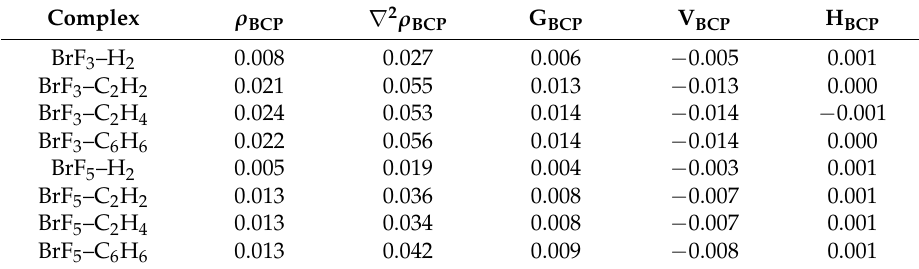
Table 3. The Quantum Theory of ‘Atoms in Molecules’ (QTAIM) parameters (in au) of bond critical point (BCP) of the Lewis acid—Lewis base bond path; electron density at BCP, ρ BCP , its laplacian, ∇ 2 ρ BCP , the total electron energy density at BCP, H BCP , kinetic, and potential energy components of the latter value, G BCP , and V BCP ,